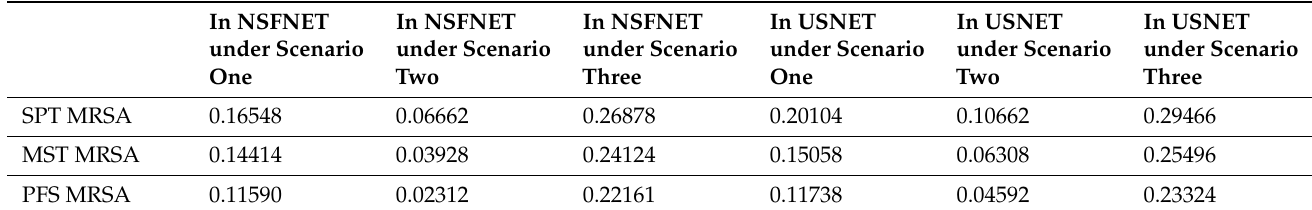
Table 1. Simulation results on service blocking probability in different scenarios when the traffic load is 200